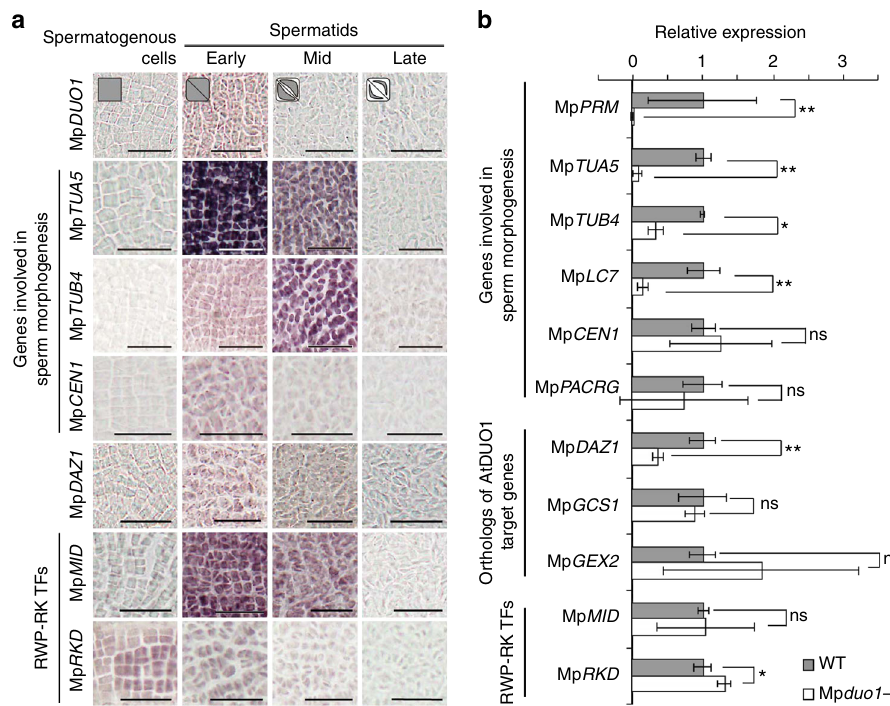
Fig. 5 Characterization of potential DUO1 target genes in Marchantia. a RNA in situ hybridization of genes involved in sperm morphogenesis, the ortholog of At DAZ1 and At DAZ2 genes, and RWP-RK transcription factors during spermatogenesis (see Supplementary Figure 2 for sense-probe controls). Bars, 25 μ m. Cell shape schematics (top) represent the developmental stages referred to in Fig. 1c. b Expression levels of genes involved in sperm morphogenesis, the ortholog of AtDUO1 target genes, and RWP-RK transcription factors in antheridiophores of WT (gray bars) and Mp duo1-1 ko (white bars). The expression of each gene in WT is set to 1. Error bars indicate mean ± SD; n = 3 (* p < 0.05; ** p < 0.01; ns, not signi fi cant; Student ’ s t